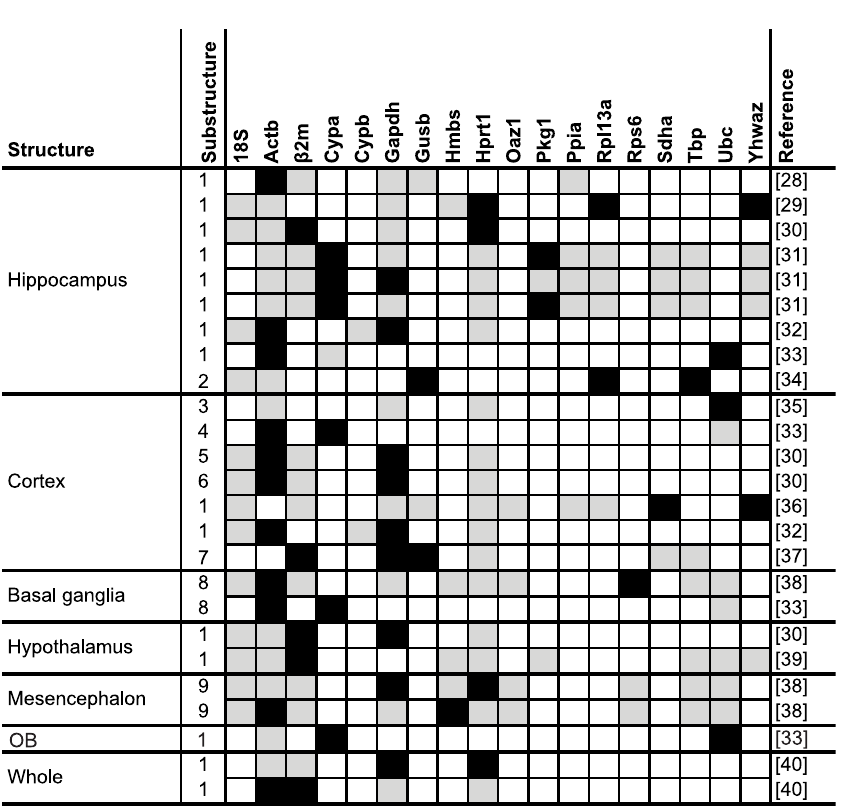
Fig 7. Testing and selection of RGs in different structures of the rat brain after various treatments. Shading in grey indicates the gene was tested and black indicates it was selected as within the group of most stable genes required for accurate normalisation. OB is the olfactory bulb with cerebral substructure codes provided as a footnote. Only genes tested more than once included. See S4 Table for further details of each study, including treatment regime and full list of all RGs tested and selected. a Substructures : 1 = Whole , 2 = Dendate gyrus , 3 = Auditory , 4 = Prefrontal , 5 = Frontal , 6 = Temporal , 7 = Whole + Basal ganglia , 8 = Striatum , 9 = Nigra